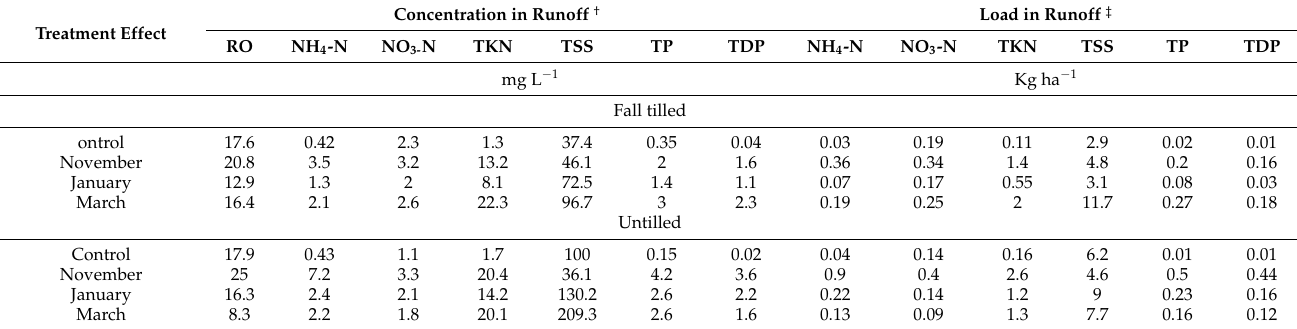
Table 5. Runoff and nutrient concentrations and loads in snowmelt, as influenced by tillage and time of manure application; Brookings, SD, 2010.